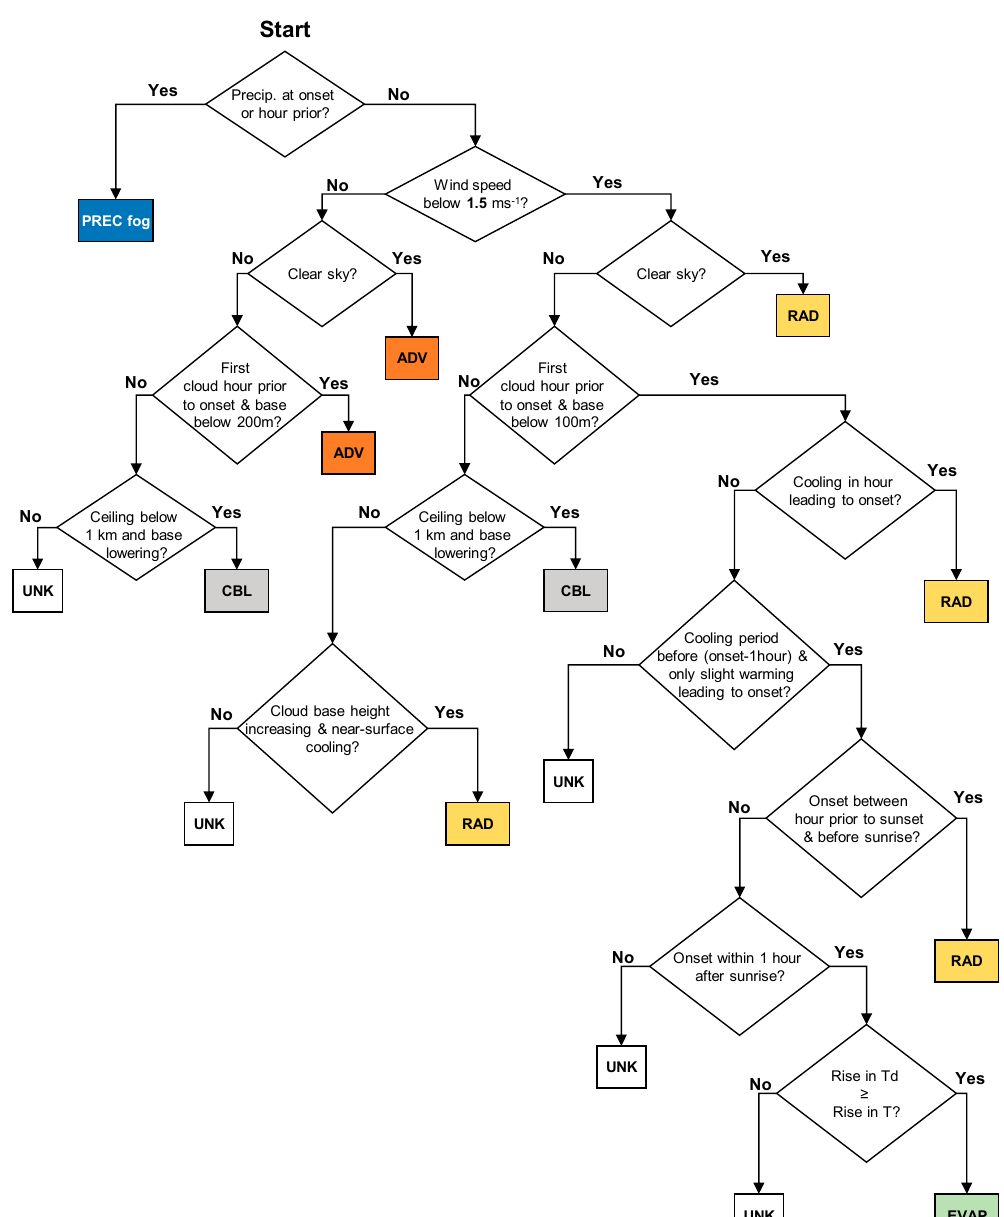
Figure 3. Flowchart for type of fog classification. (Adapted from Tardif and Rasmussen (2007)).